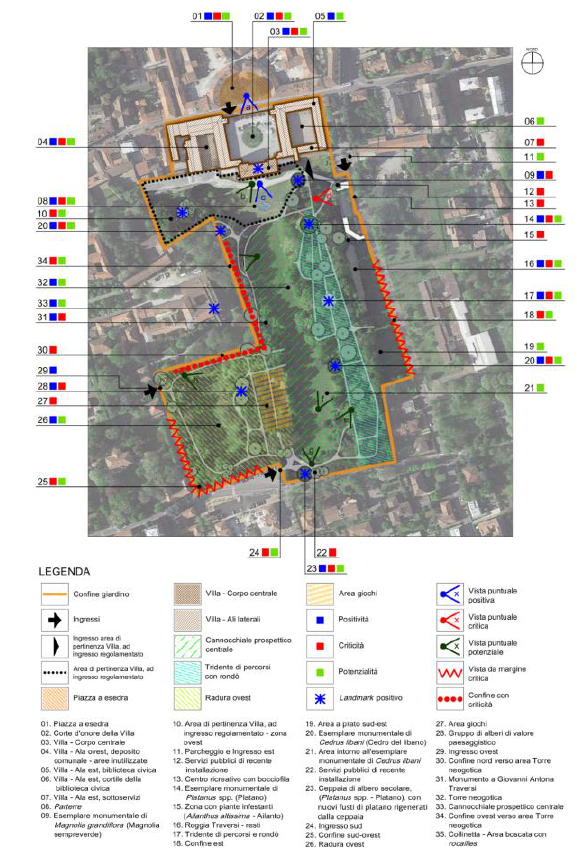
Figure 7. Plan of Villa Cusani Tittoni Traversi garden in Desio (Monza and Brianza Province), where elements and areas of special historic, architectural and botanic interest are shown, as well as the survey of decay, alteration and transformation issues, and site potentials. All these elements have to be considered to elaborate a Management Plan.